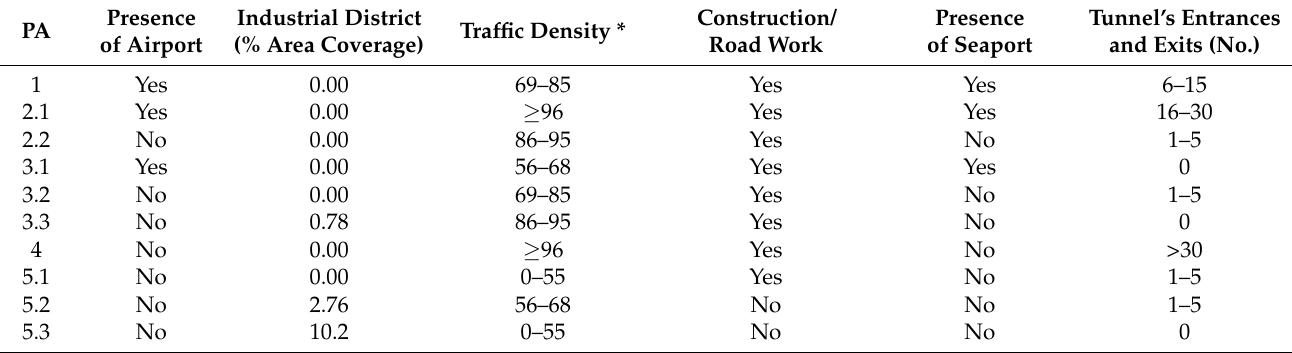
Table 1. Potential air pollution sources in the city of Rio de Janeiro